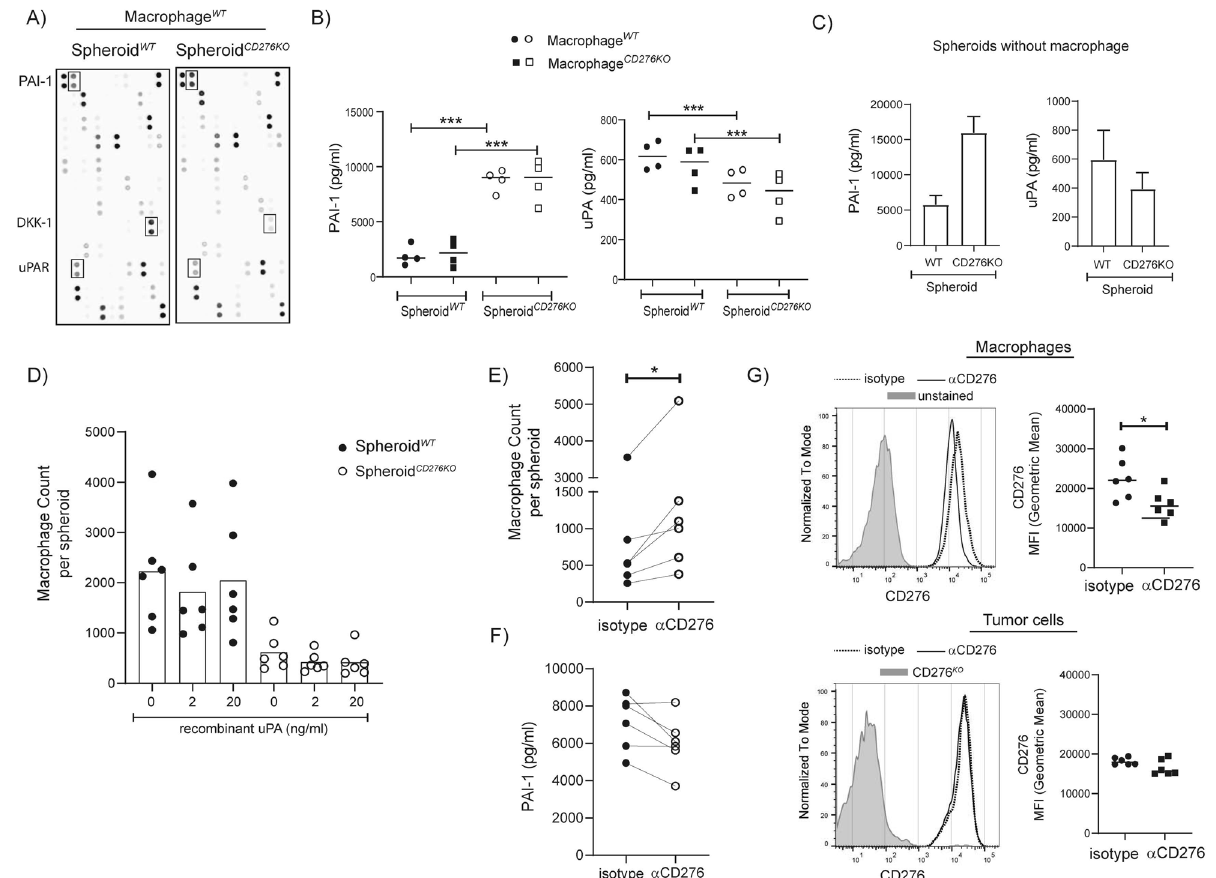
Figure 4. In the absence of CD276 on tumor, soluble PAI-1 is increased, while uPA is decreased. (A&B) Spheroids formed from HCT116 WT or HCT116 CD276KO were cocultured with Macrophages WT or Macrophages CD276KO (M-CSF) for 4 days and supernatants were collected. ( A) Proteome Profiler Cytokine Arrays from equal volume of supernatants from Spheroid WT or Spheroid CD276KO cocultured with the same Macrophages WT are presented here. ( B) The graphs summarize the concentration of PAI-1 and uPA in the supernatants performed with relevant ELISA for indicated samples. ( C) Spheroids were cultured without macrophages for the same period (5 days after initial seeding + 4 days after medium exchange). To collect enough supernatant, 5 wells from each group were pooled into one sample. PAI-1 and uPA concentrations were analyzed with ELISA. The data is from three independent experiments. ( D-F) Spheroids formed from HCT116 WT or HCT116 CD276KO cells were cocultured with macrophages (7 days cultured in M-CSF supplemented medium, no gene editing) for 4 days. Quantifications for CD11b + infiltrated macrophages were done by flow cytometry. 6–10 spheroids from each group were pooled into one sample, and before dissociating the spheroids, a defined number of beads (negative compensation beads for flow cytometry) was added. The ratio of recorded bead counts to initial bead amount was used to back calculate MDMs per spheroid. ( D) Spheroids and macrophages were cultured in the absence or presence of recombinant uPA protein with indicated concentration. Six macrophage donors in total were tested. ( E–F) Spheroid WT cocultured with macrophages were treated with 20 µg/ml αCD276 antibody or isotype control. ( E) Graph depicts the count of infiltrated macrophages per spheroid from six different donors. ( F) The graph summarizes the concentration of PAI-1 in the supernatants from indicated samples ( G) CD276 expression on macrophages and tumor cells treated with αCD276 antibody or isotype controls were analyzed. Histograms represent experiment with one macrophage donor and tumor cells in the same sample, and the graphs summarize the data from six donors and corresponding tumor cells. Dotted line indicates isotype treated controls, black line αCD276 antibody treated samples. Statistical analysis was done with paired t -test; **p < 0.01; ***p <